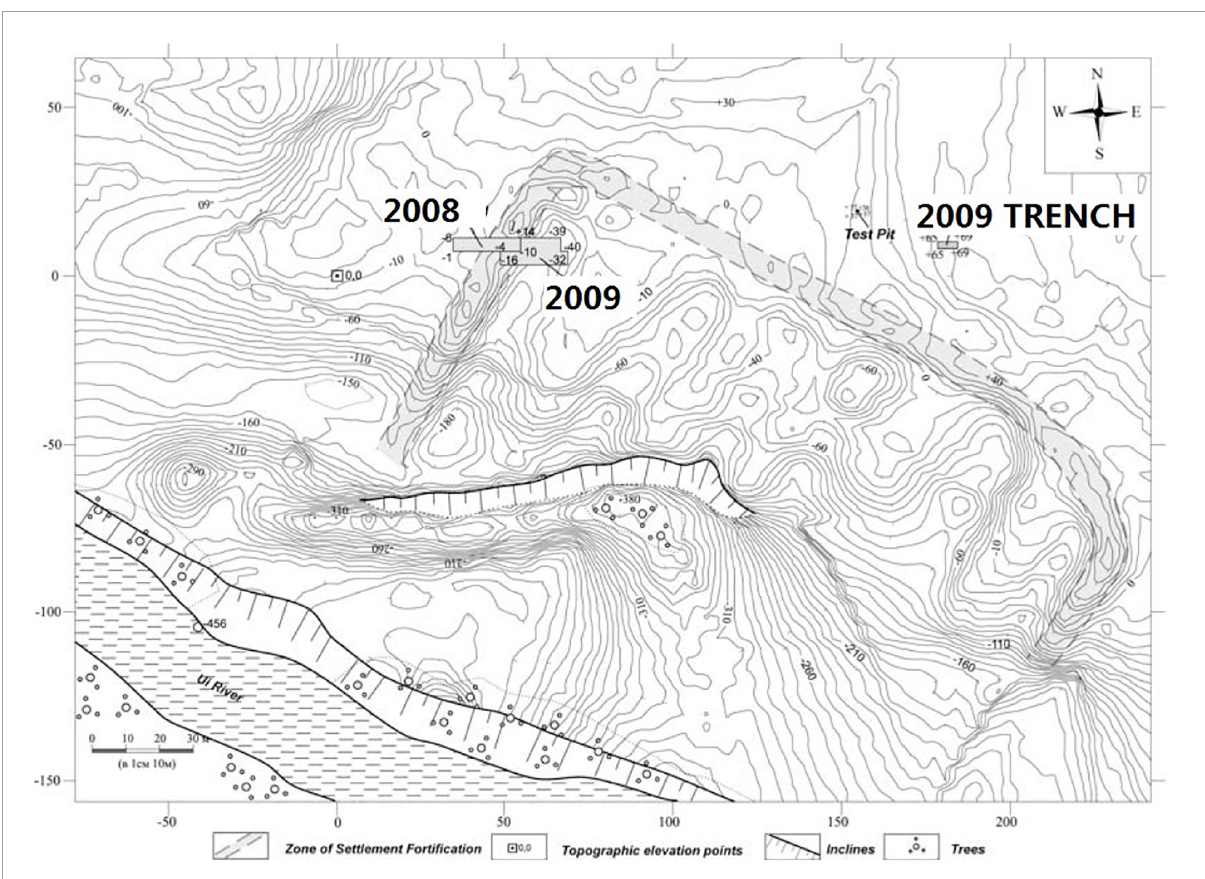
FIGURE3 Images of the Stepnoye settlement: lower–topographic plan showing excavation units (after Hanks and Johnson,